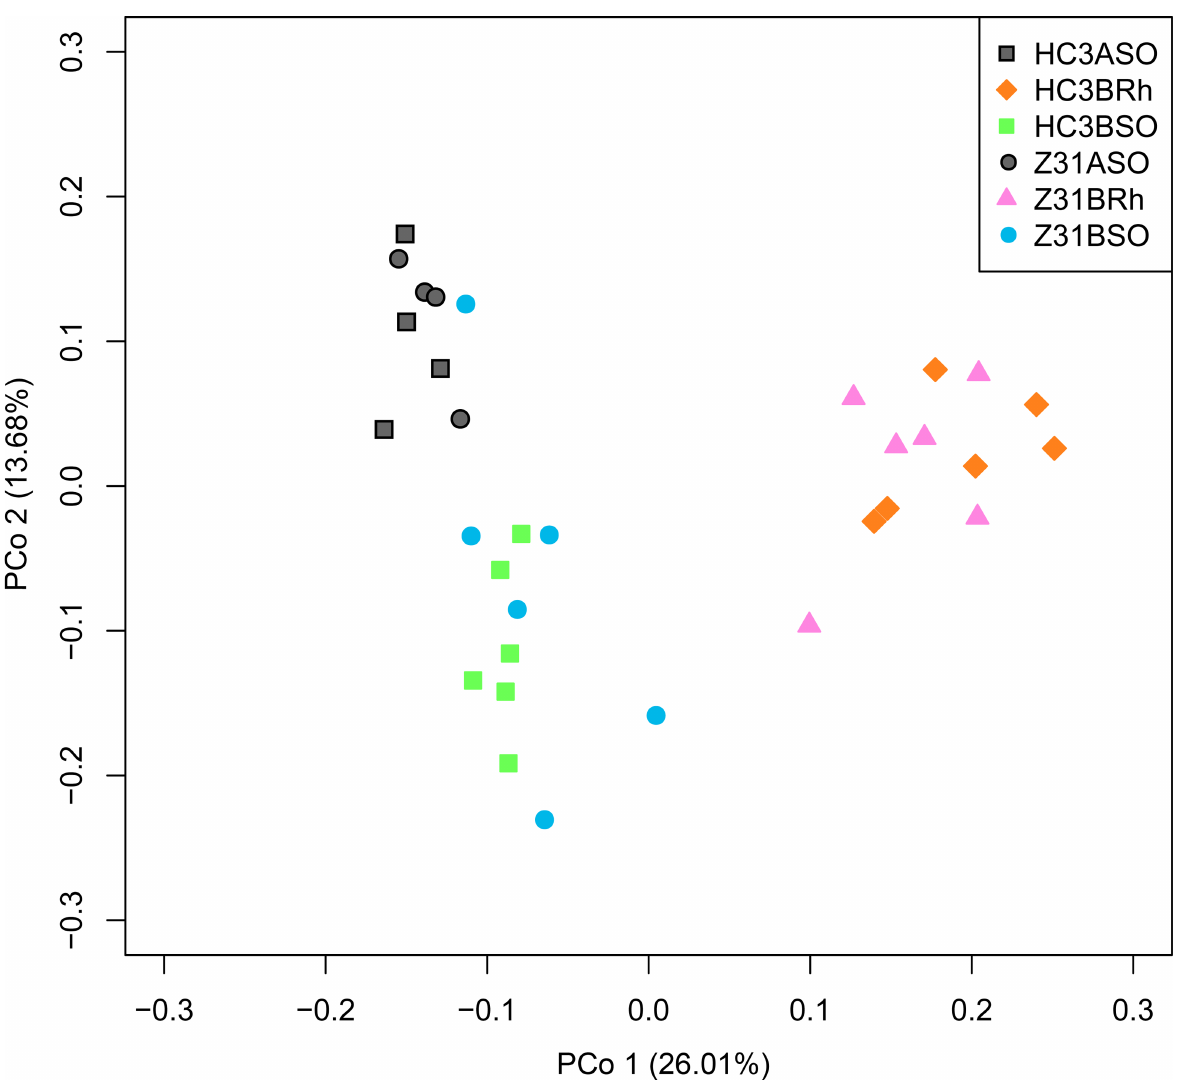
Fig 1. Principal coordinate analysis (PCoA) based on the Bray–Curtis distance metrics of bacterial communities between the 5-enolpyruvy- lshikimate-3-phosphate synthase ( EPSPS )-transgenic soybean line ZUTS31 (Z31) and its recipient cultivar Huachun3 (HC3) at the vegetative stage (n = 32). HC3BRh and Z31BRh represent the rhizospheric soils of the recipient cultivar HC3 and the transgenic line Z31 at the vegetative stage, respectively. HC3BSO and Z31BSO represent the surrounding soils of the recipient cultivar HC3 and the transgenic line Z31 at the vegetative stage, respectively. HC3ASO and Z31ASO represent the bulk soils before sowing seeds of the recipient cultivar HC3 and the transgenic line Z31, respectively.